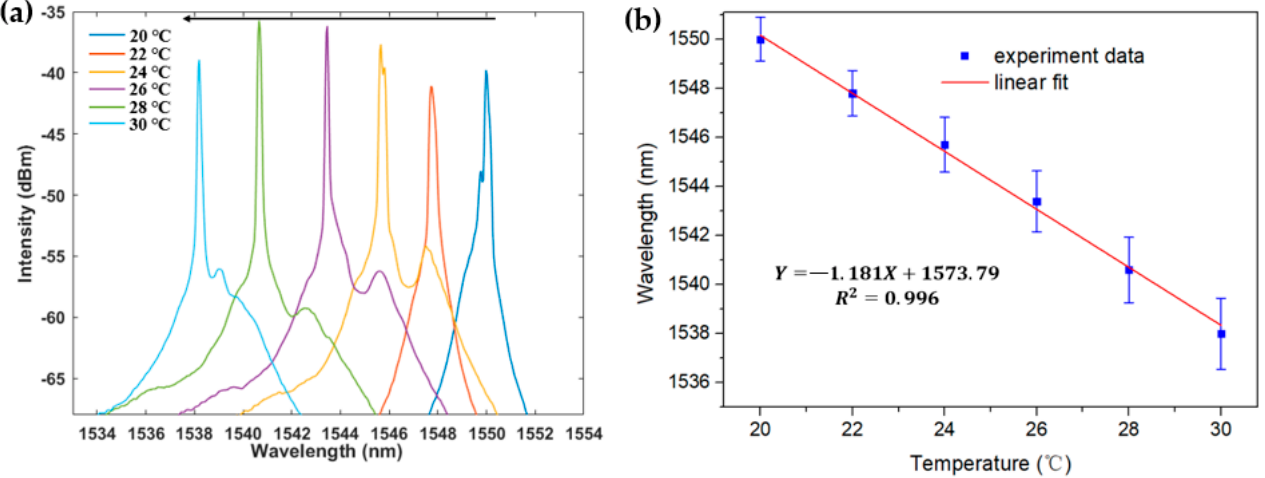
Figure 7. Temperature response of the LC filled HCF structure in FRL. ( a )Transmission spectra of the fiber laser temperature sensor system when T changes from 20 °C to 30 °C with the steps of 2 °C. ( b ) Variations of the emission wavelength.